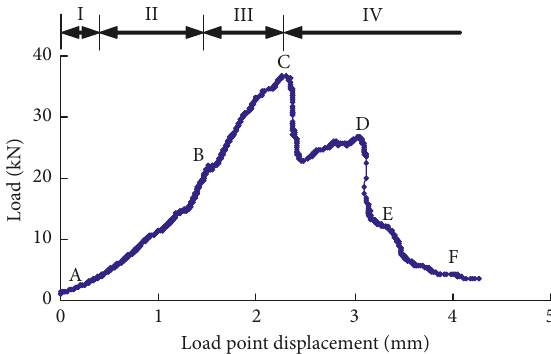
Figure 3: Load-displacement curve of rock samples.